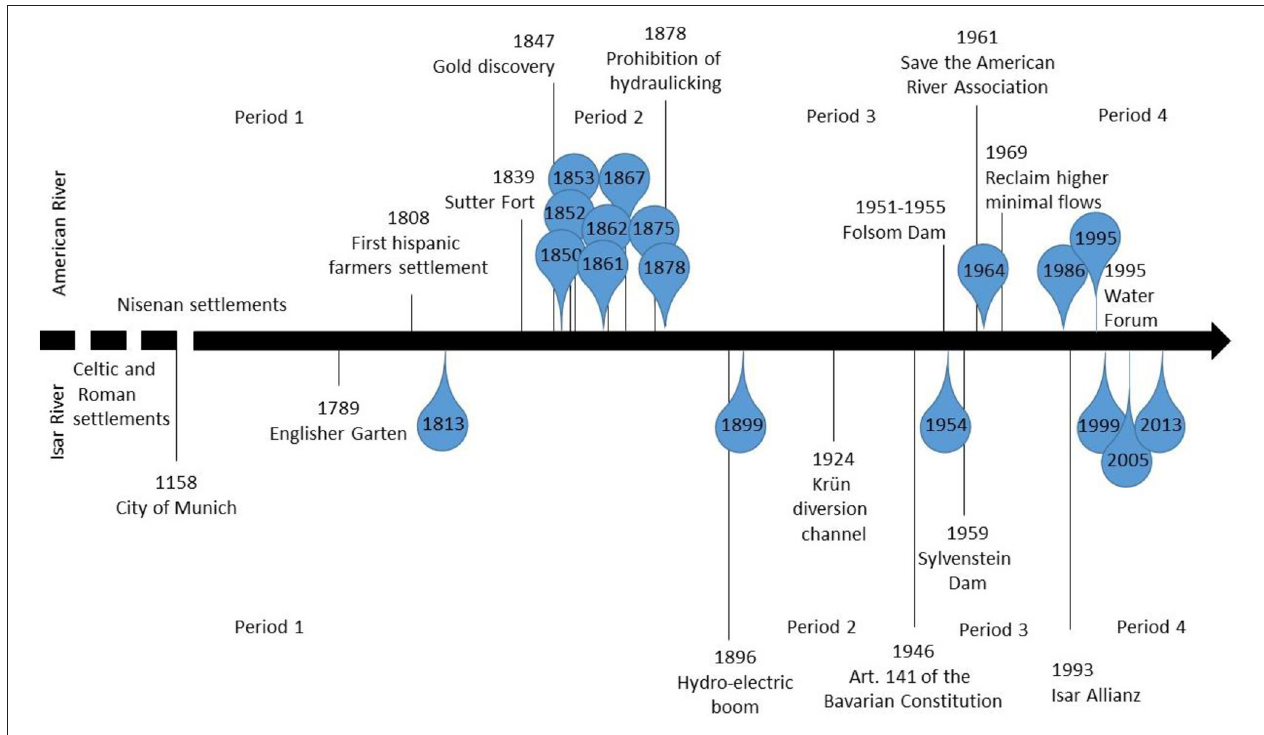
FIGURE 7 | River history